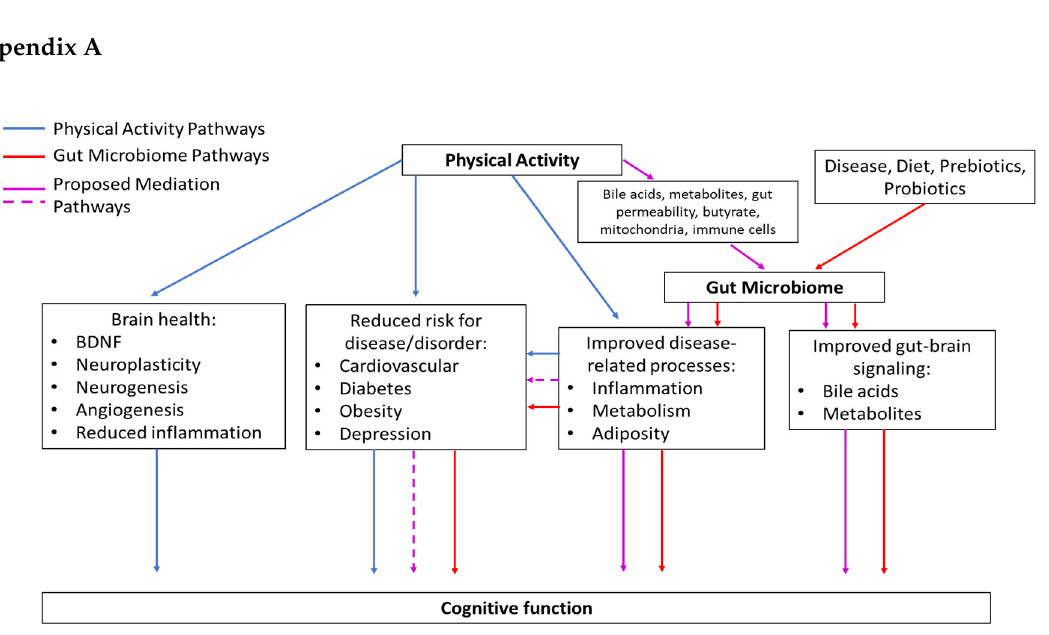
Figure A1. Proposed model depicting the mediation of the effects of physical activity (PA) on cognitive function by the gut microbiome .